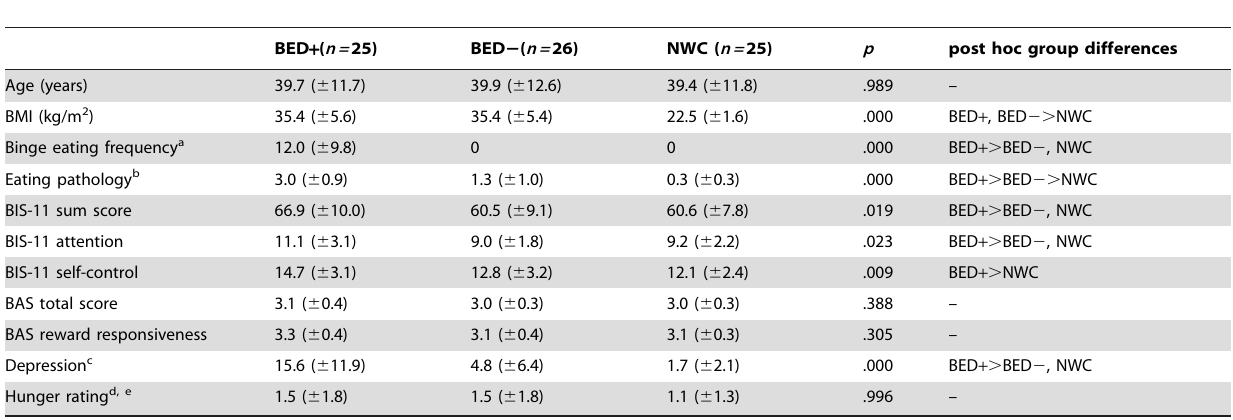
Table 1. Mean ( 6 standard deviation) of sample characteristics in each study group.